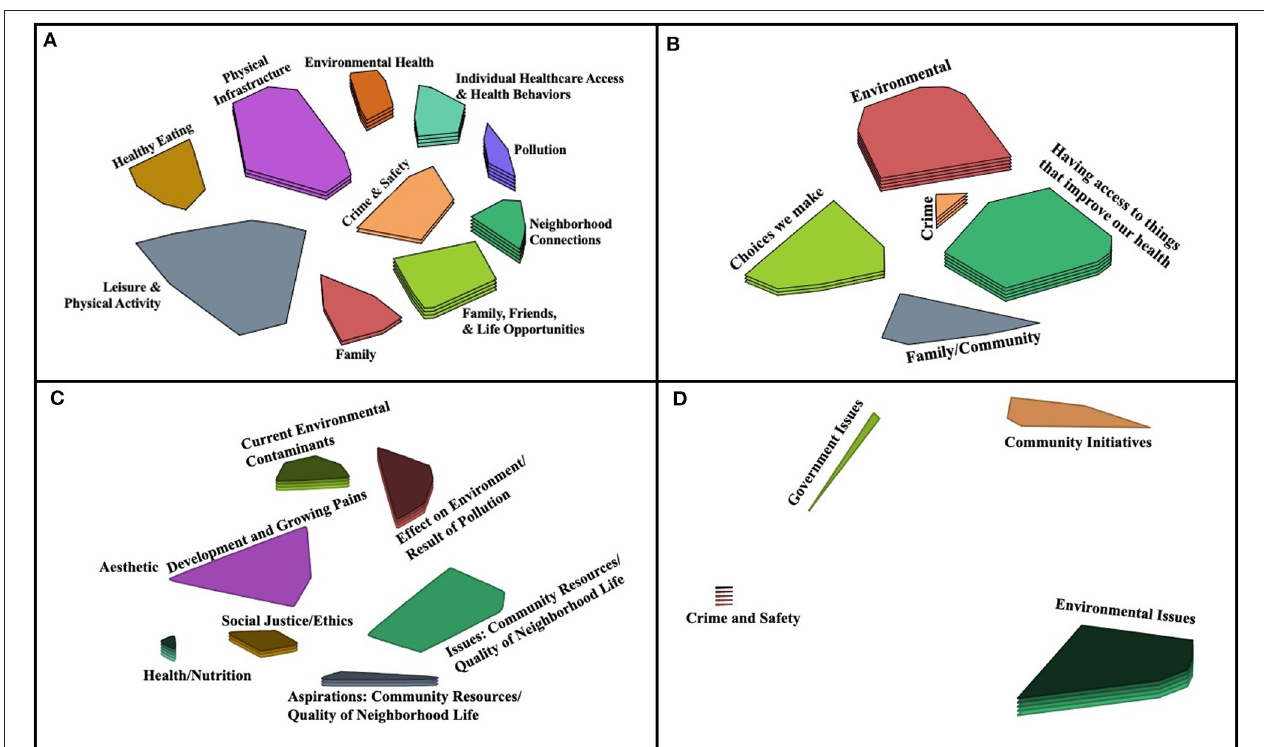
FIGURE 2 | Final Concept Maps by Community. The cluster rating maps depict the final concept map chosen by each community ( A : Community A; B : Community B; C : Community C; and D : Community D). Clusters in close proximity are more closely related than distant clusters. In (C) , the Aesthetic cluster represents a single statement that the community did not perceive as belonging with any of the other clusters and so chose to leave